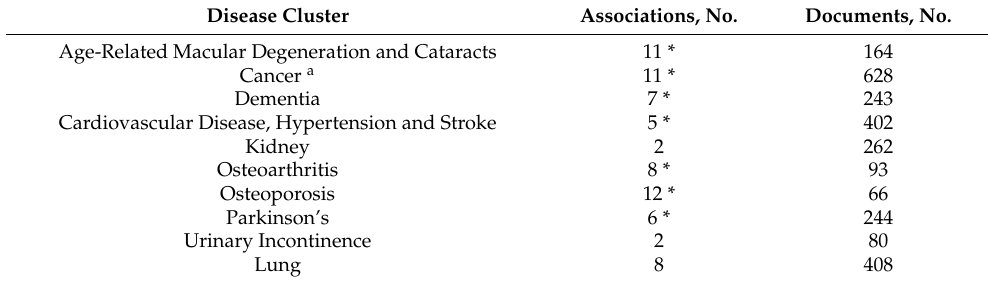
Table 1. Number of associations and patient education documents of chronic medical conditions. Disease Cluster Associations, No. Documents, No. Age-Related Macular Degeneration and Cataracts 11 * 164 Cancer a 11